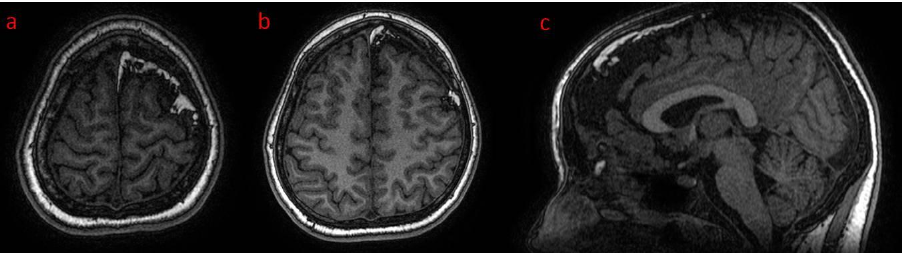
lipomatosis; ( c ) SWI—subtle calcification artifacts.